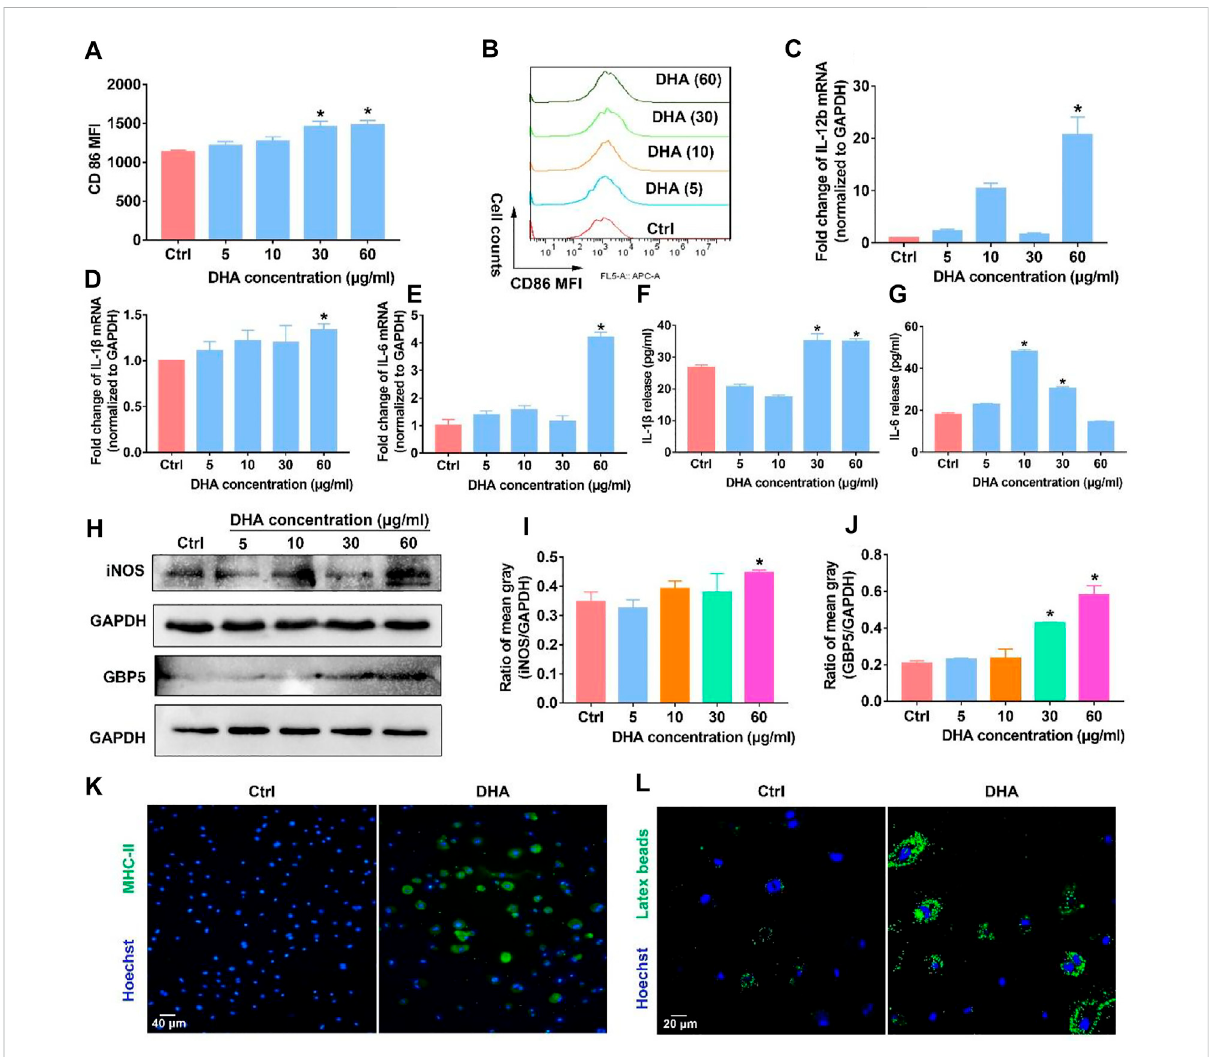
FIGURE 1 DHA remodeled macrophages into the M1 phenotype in vitro . (A,B) The membrane expression of CD86 was assayed through fl ow cytometry. (C – E) mRNAexpressionofIL-1 β ,IL-6, andIL-12b wasinvestigatedusingtheRT-PCR. (F,G) ReleaseofIL-1 β and IL-6wasdetectedusingtheElisaKit. (H – J) WB was applied to measure the expression of iNOS and GBP5. The mean gray was quantitatively analyzed. (K,L) The functions of antigen presentationandphagocytosisweredetected,asevidencedbyMHC-IIexpressionandlatexbeatsexperiments.Geometricmeanswereusedto quantify the MFI. Values were means ± SD ( n = 3, * p < 0.05 when compared with the control